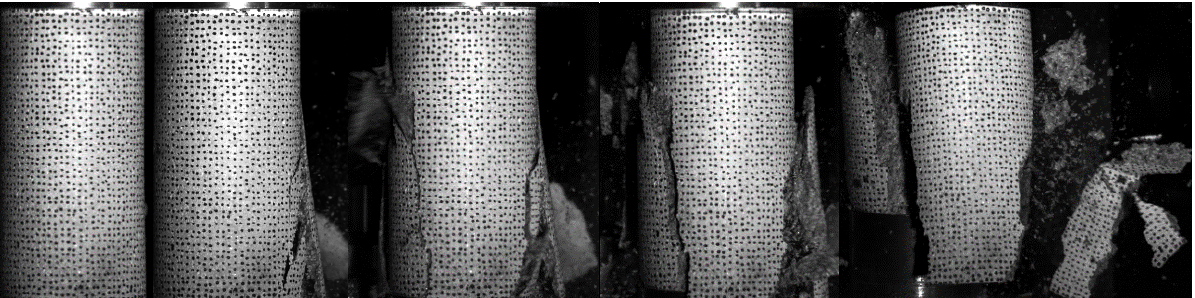
Figure 16. Image of the failure process of specimen D10.